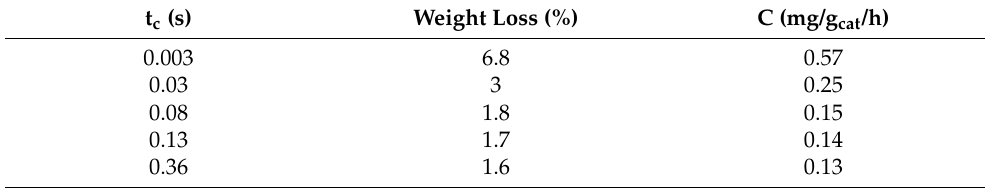
Table 5. The weight loss of Ni/CeZrO 2 samples and the rate of carbon deposition after toluene steam reforming carried out at S/C = 2.4 and different contact times (t c ) at temperatures ranging from 420 to 800 °C (TOS at each temperature = 24 h).